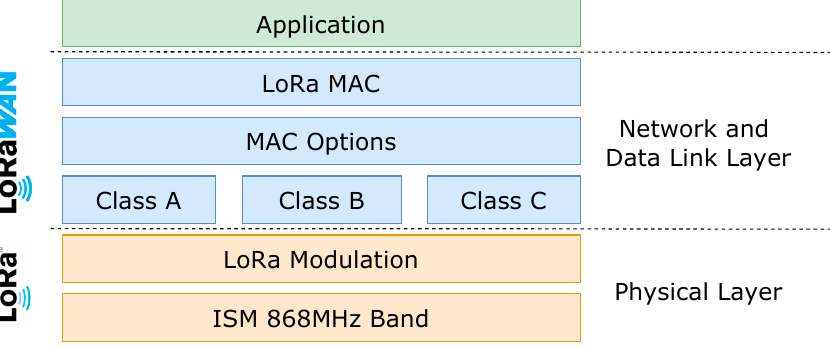
Figure 2. LoRaWAN layers.